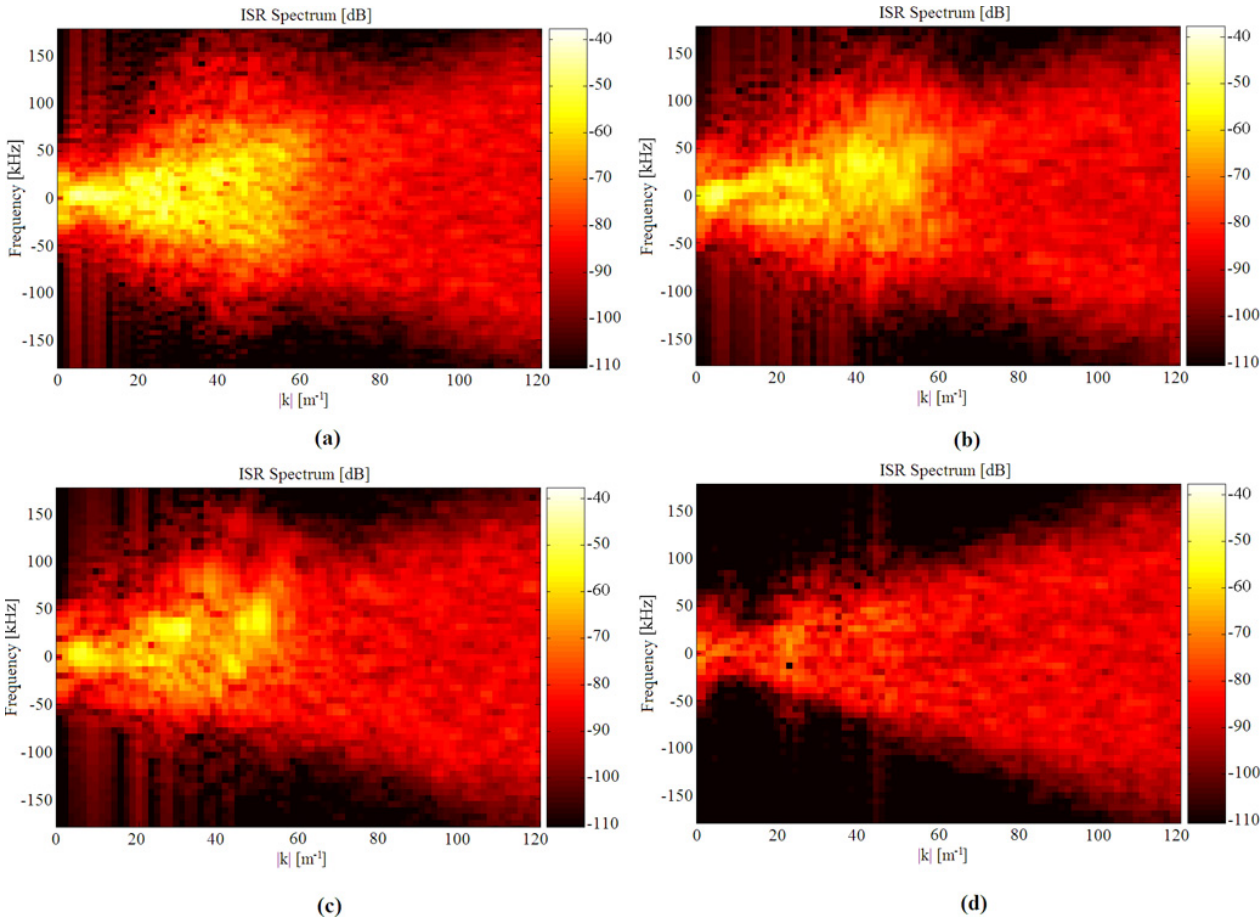
Fig. 6. Ion acoustic line of incoherent scatter spectrum for simulations with parameters presented in Sect. 3.1 for (a) n b = 1 × 10 9 m − 3 ,